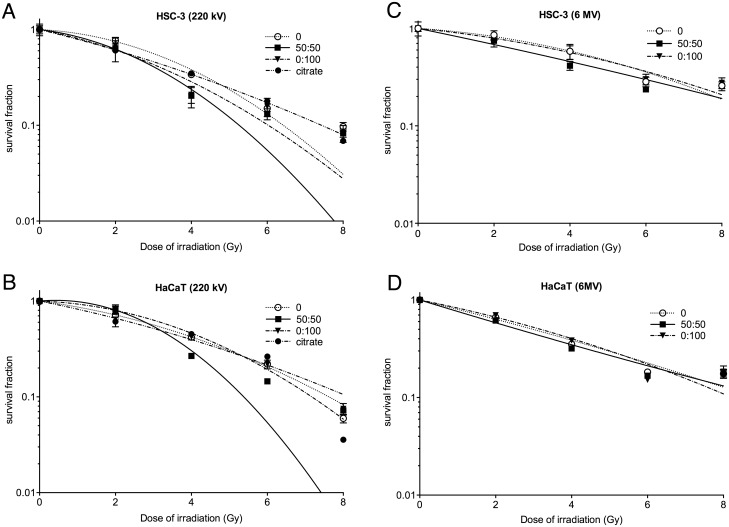
Normalised survival fractions of (A,C) HSC-3 and (B,D) HaCaT cells following exposure to αGal:PEG-amine AuNPs at their HSC-3 IC50 concentrations, followed by different doses of (A,B) 220 kV X-rays or (C.D) 6 MV X-rays.Data are presented as the mean survival fraction ±SEM. A linear-quadratic curve was fitted to each data series.